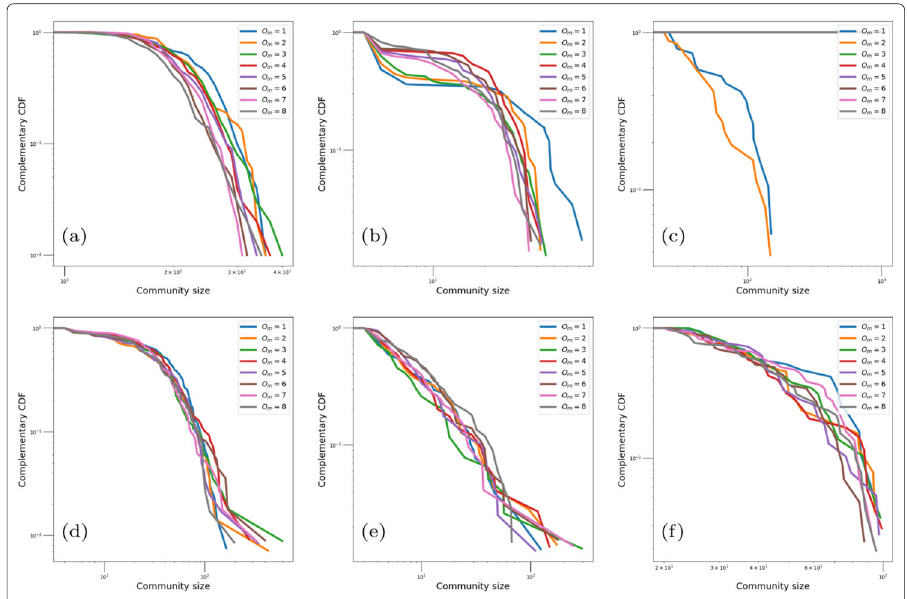
Fig. 22 Variation of the maximum number of memberships ( O m ) for LFR synthetic networks considering the community size: a Bigclam; b CFinder; c Copra; d Demon; e SLPA; f